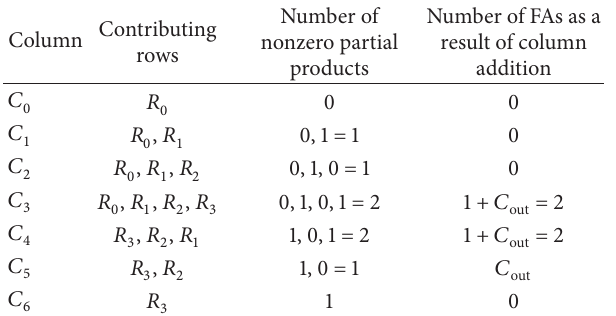
Table 5: Example number of FAs for 𝑚 = 4 (constant = 4 󸀠 b1010). Number of Contributing Column rows